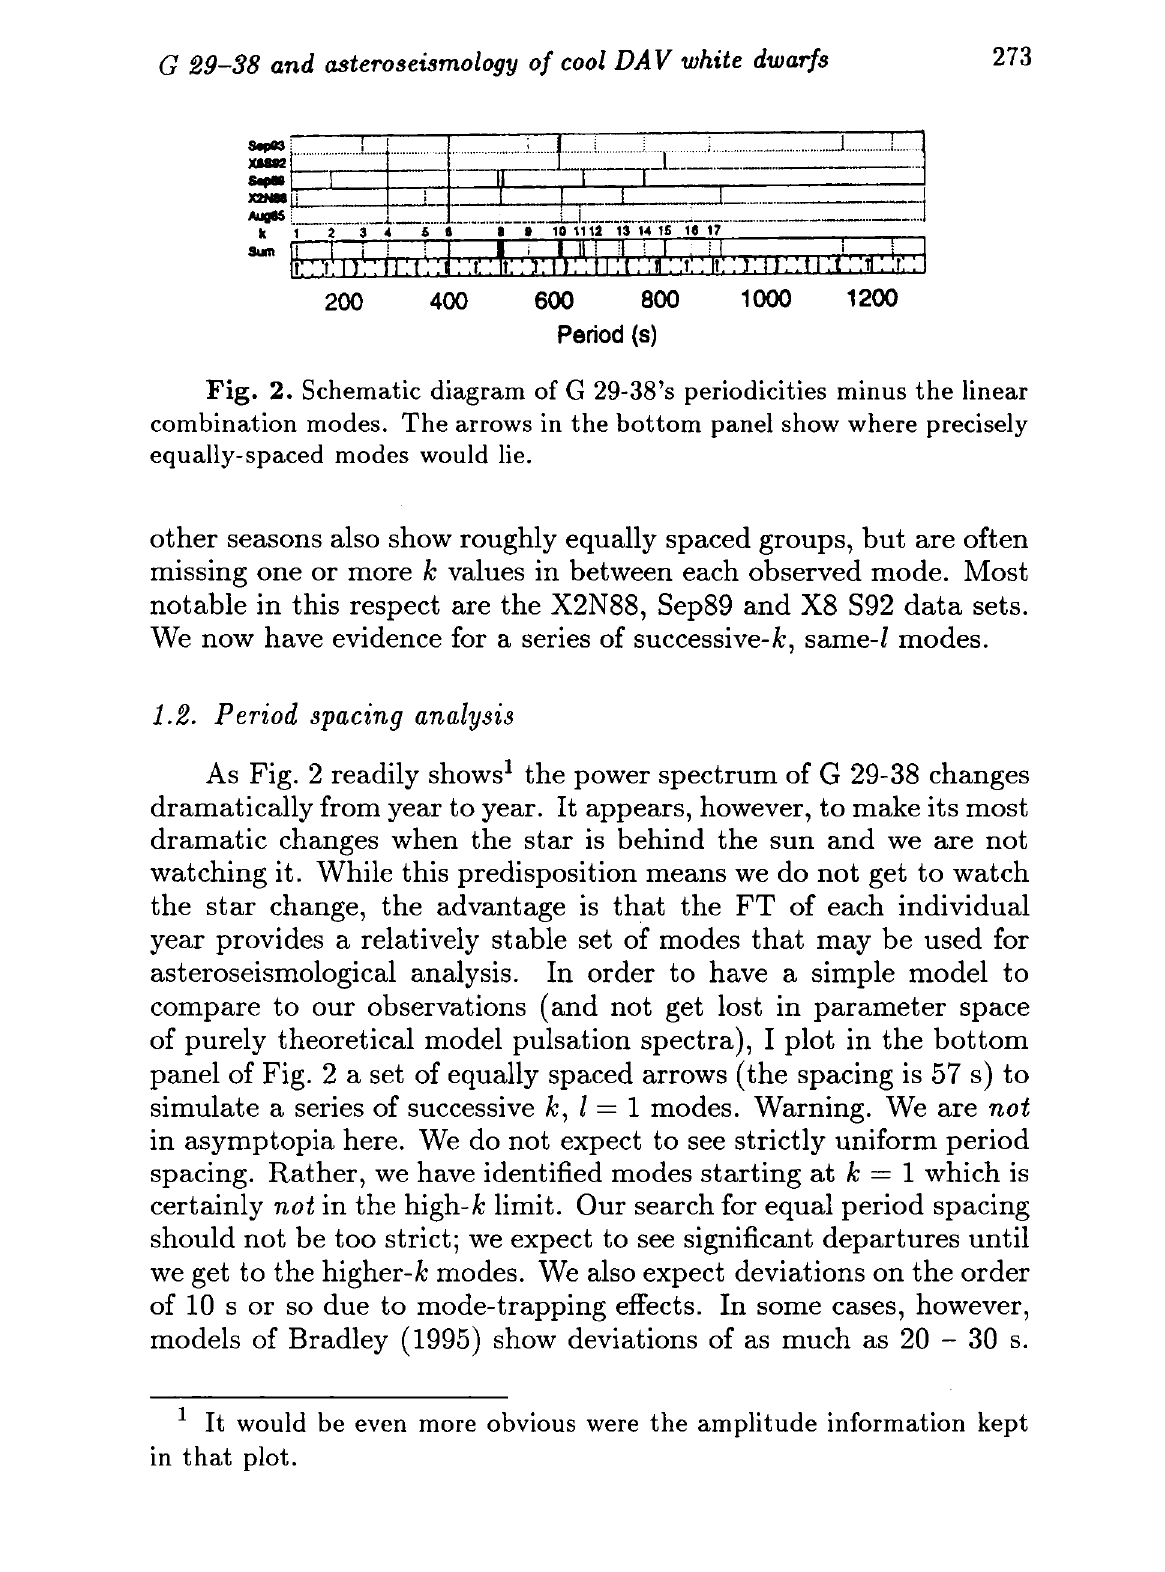
Fig. 2. Schematic diagram of G 29-38's periodicities minus the linear combination modes. The arrows in the bottom panel show where precisely equally-spaced modes would